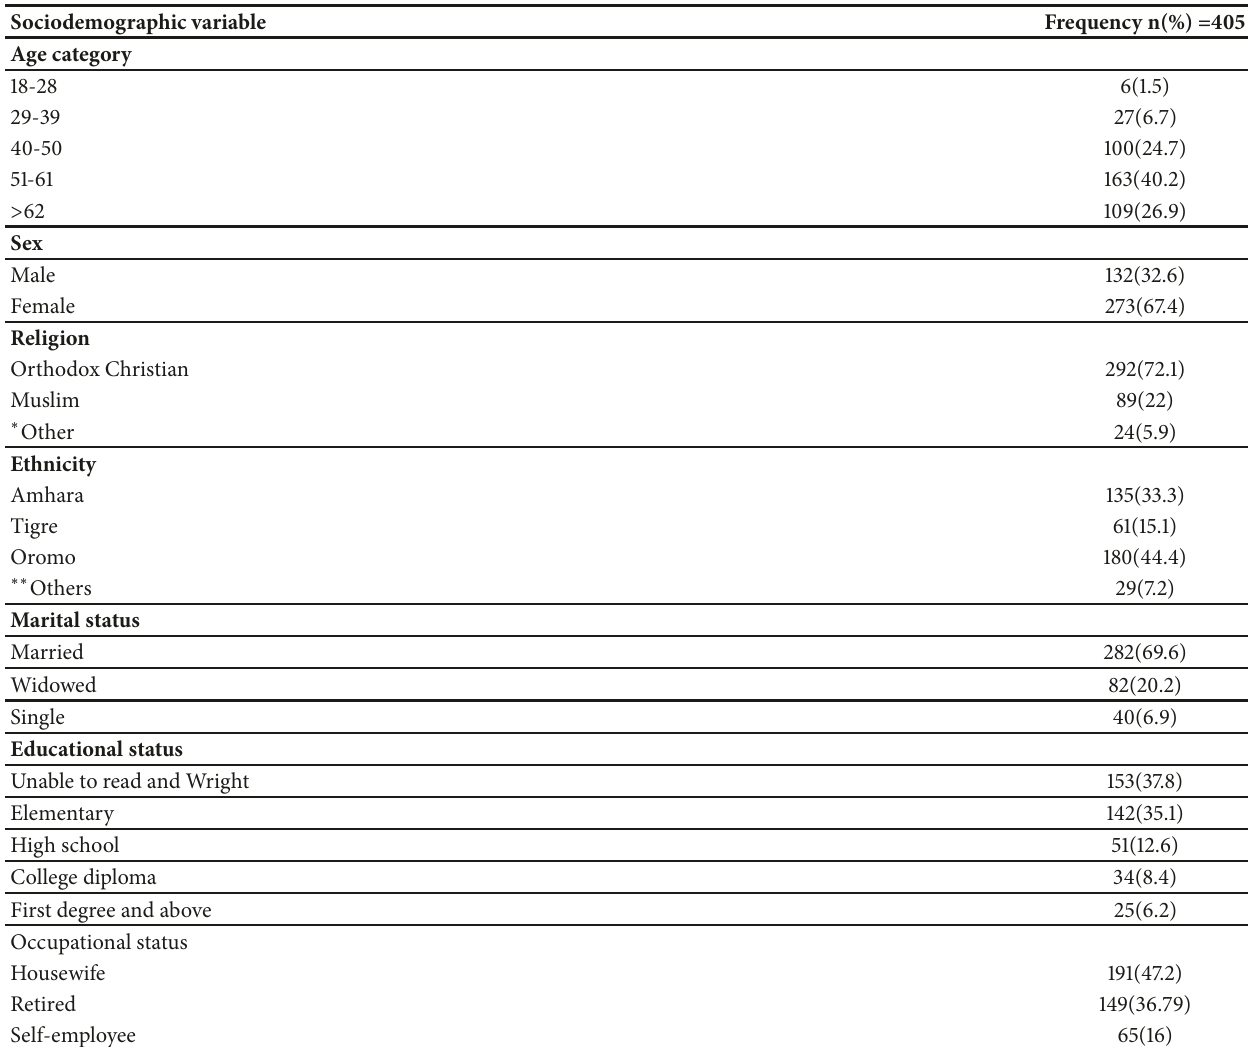
Table 1: Sociodemographic characteristics among asthma patients at governmental hospital Addis Ababa, Ethiopia,